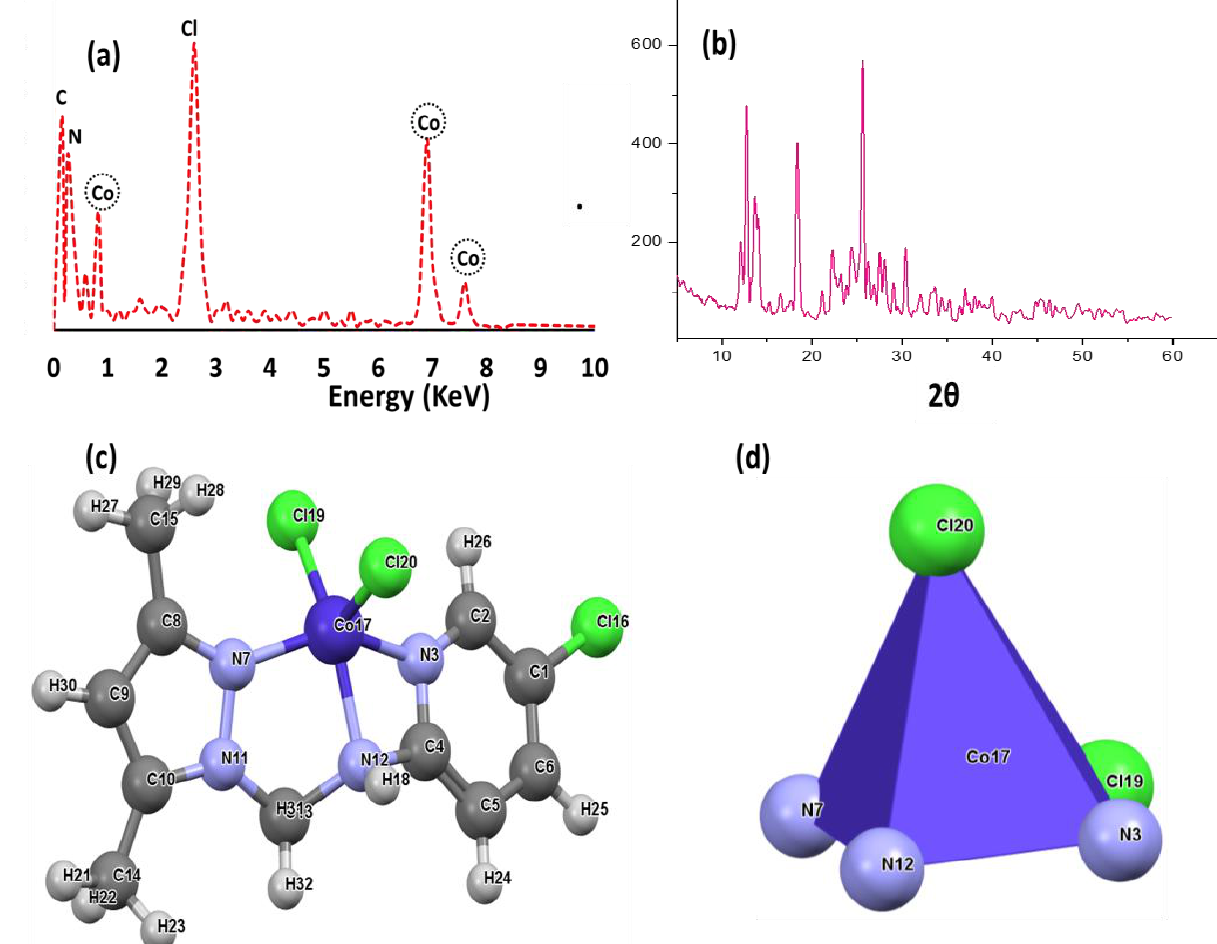
Figure 1. ( a ) EDX analysis of the Co(II)/pyrazole complex, ( b ) PXRD spectra of cobalt complex, ( c ) DFT-optimization and ( d ) geometry. Table 1. DFT structural parameters.